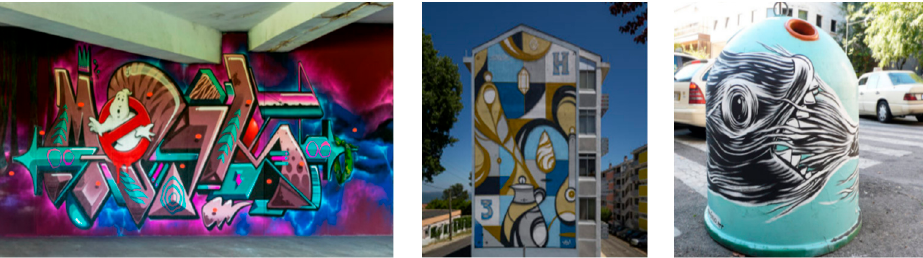
Figure 2. Examples of images with street art graffiti.